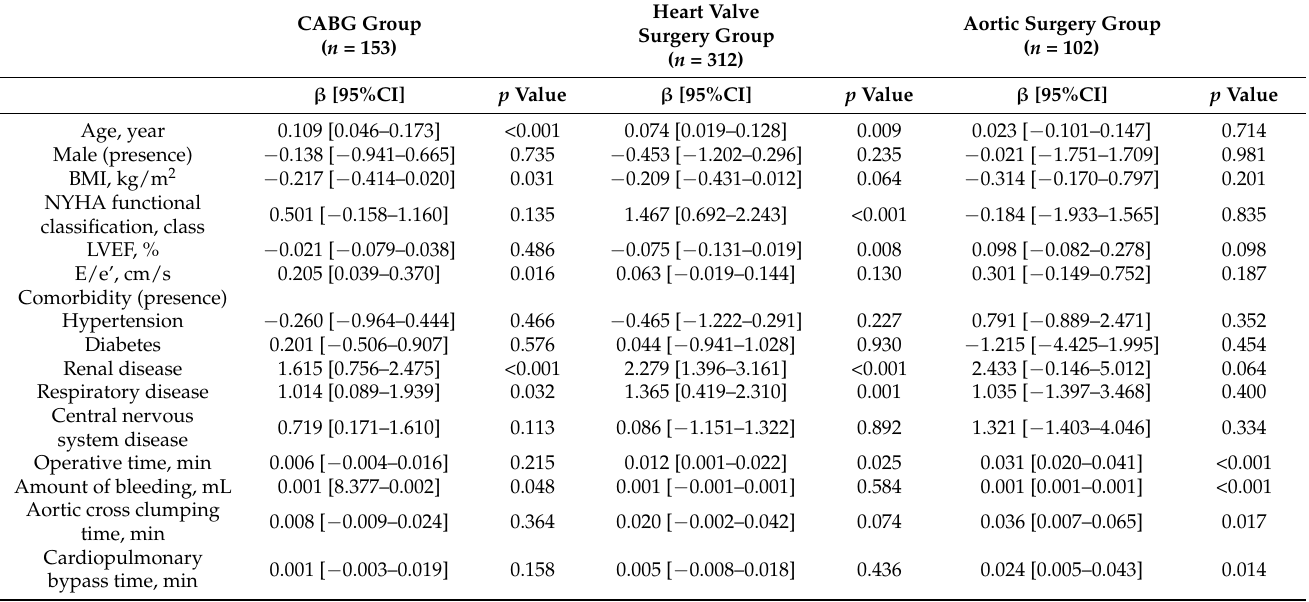
Table 2. Single liner regression analysis for determining factors for achieving independent